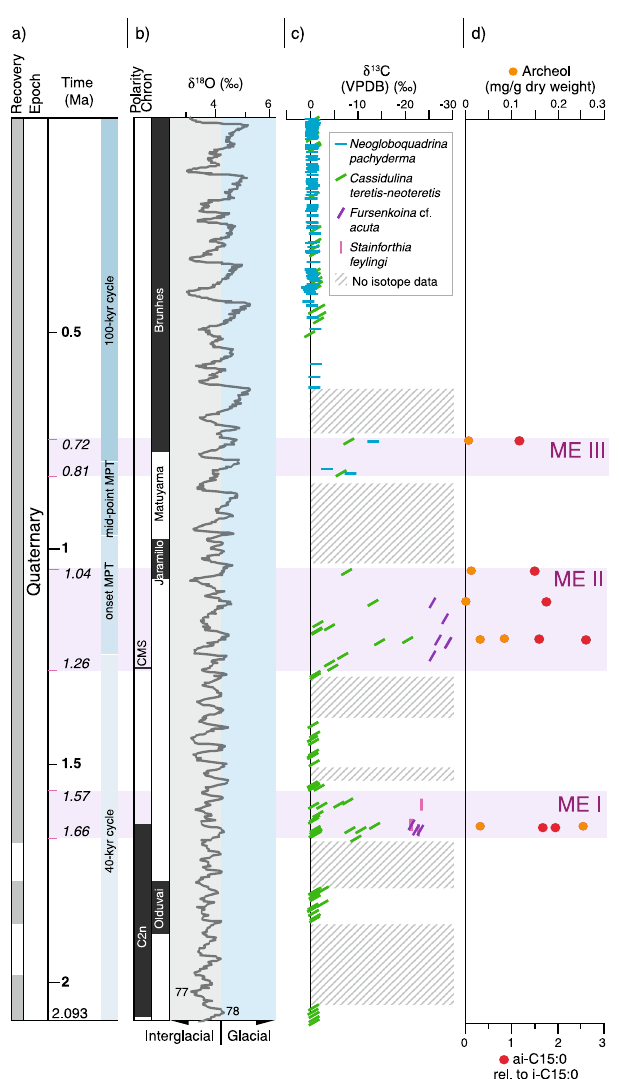
Fig. 4 Compilation of background data and biogeochemical evidence indicate methane leakages during methane excursions ME I – ME III in Hole 912A. a The recovered sediment from Hole 912A is shown in grey. Epochs and ages are according to ref. 29 . The palaeomagnetic record is from ref. 27 , where black = normal polarity and white = reversed polarity.